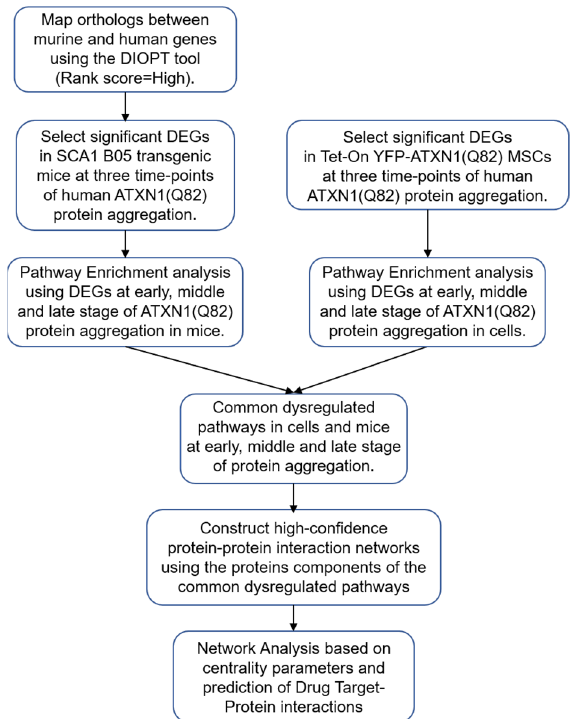
Figure 1. Data workflow for the construction of PPI networks associated to protein aggregation in Tet-On YFP-ATXN1(Q82) MSCs and SCA1 B05 transgenic mice.